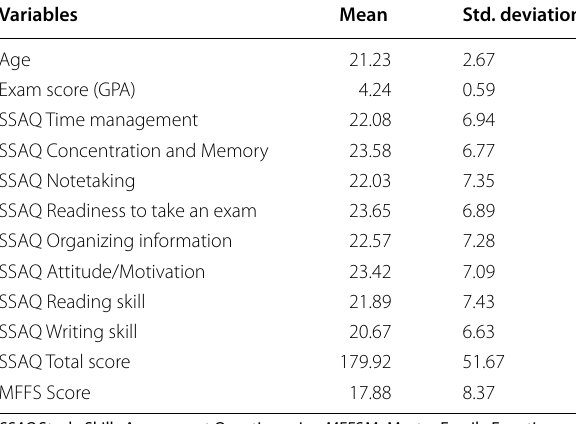
SSAQ Study Skills Assessment Questionnaire; MFFS McMaster Family Function Scale